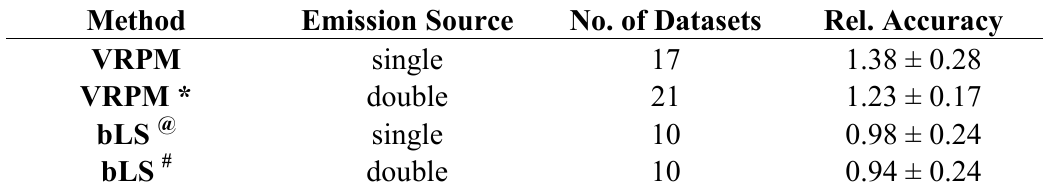
Table 1. Relative Accuracies of VRPM and bLS Techniques.